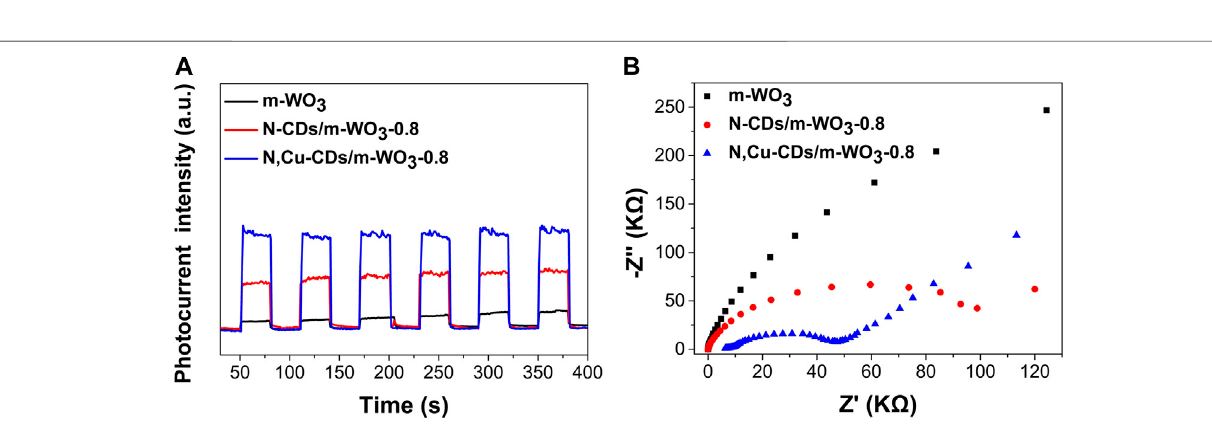
Frontiers in Materials |